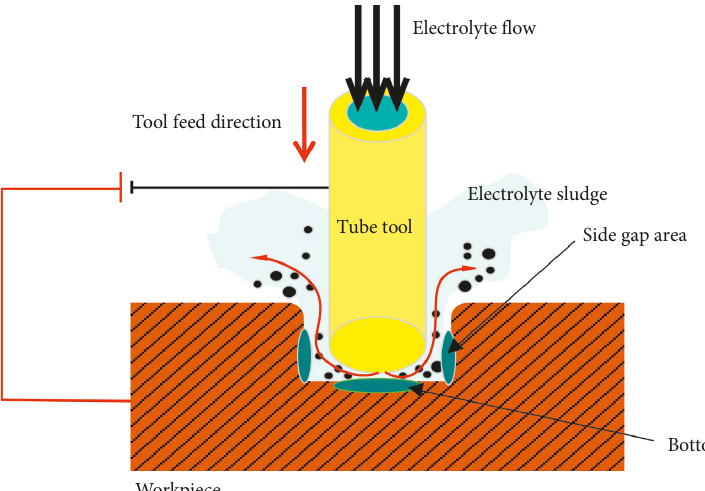
Figure 10: The schematic diagram of electrolyte fluid.